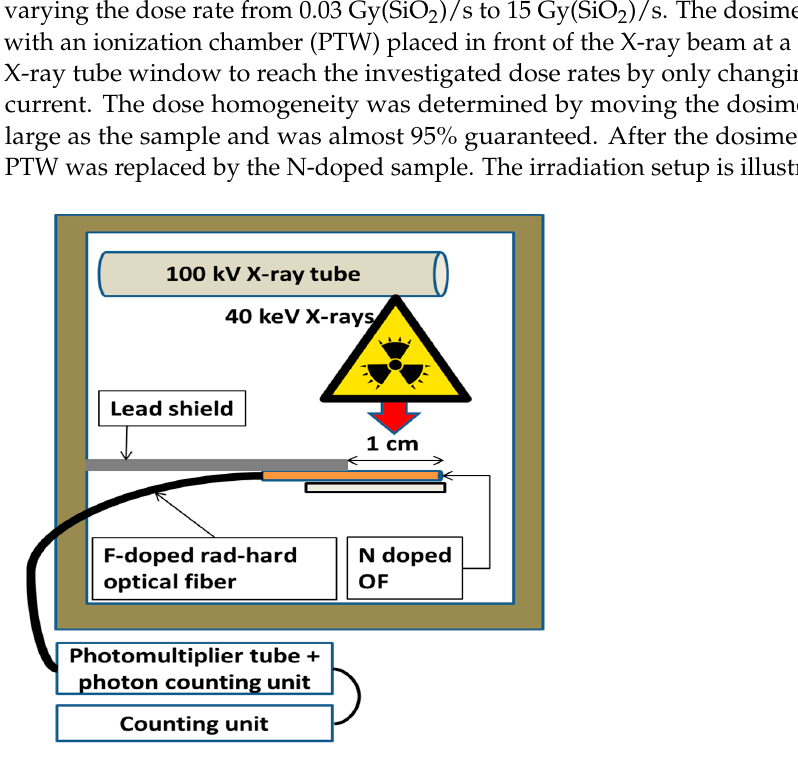
Figure 4. RIL versus dose rate calibration setup under steady-state X-ray irradiation.